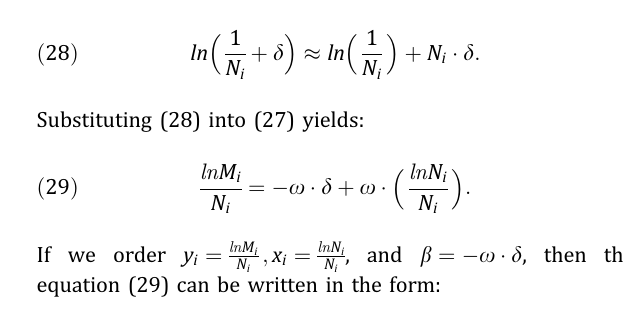
Table 1 . Observed values of age and density of universe [25] Age of universe (year) Baryon-density of universe ( kg ⋅ m (cid:1) 3